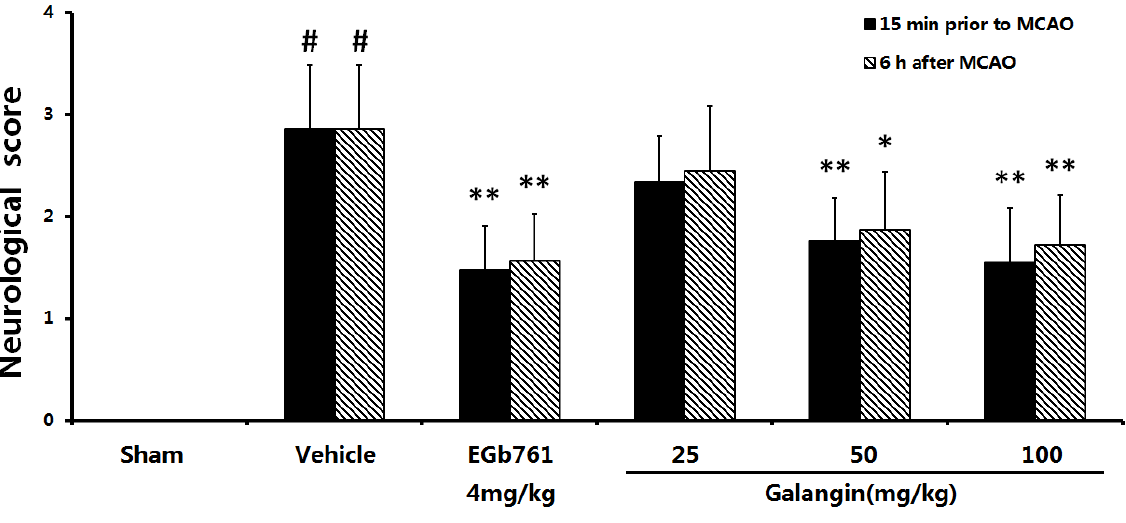
values were expressed as the means ± SD (n = 10) and the data were analyzed by one-way ANOVA. ## p < 0.01, # p < 0.05 versus the sham group; ** p < 0.01, * p < 0.05 versus the vehicle